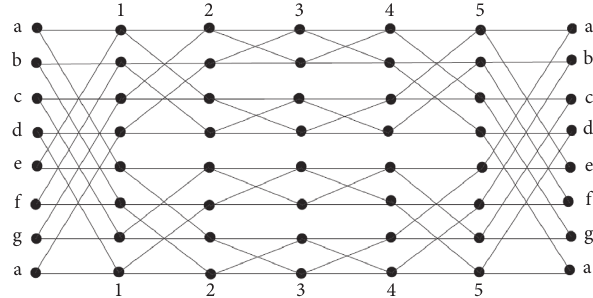
Figure 4: 3D toroidal Benes